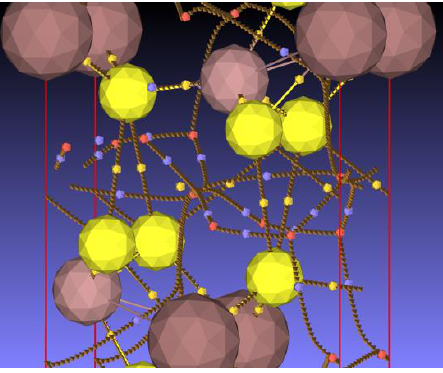
Figure 13. ( a ) Network of bond critical points (small yellow spheres), ring critical points (small red spheres), and cage critical points (small blue spheres). Sulfur atoms: large yellow spheres; gallium atoms: small brown spheres; and indium atoms: large brown spheres. ( b ) Corresponding atomic positions in the crystal structure. Sulfur in yellow, gallium in green, and indium in pink. View along the {001} direction; the gap between the layers is along the {100} direction.